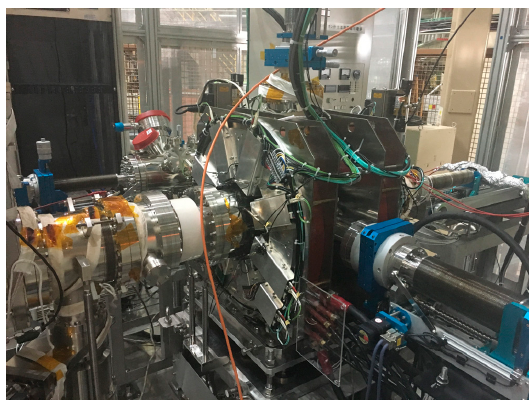
Figure 16. µSR spectrometer installed in area U1A for use in USM experiments. The entire assembly is placed in a large cage on a stage electrically isolated from the ground.